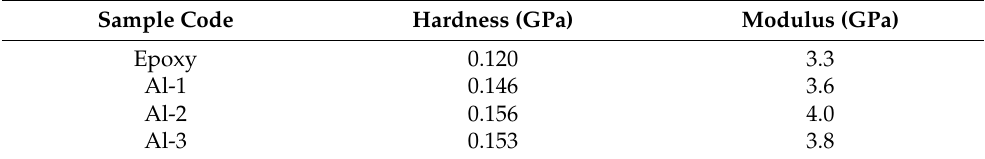
Table 4. Indentation hardness and modulus for the coatings prepared from the different Al particles. Sample Code